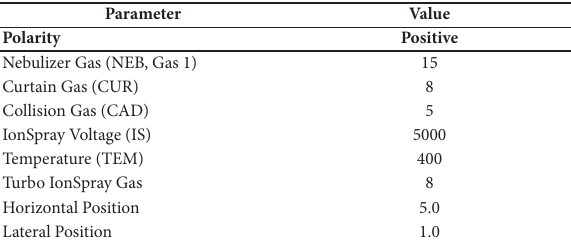
Table 1. Parameters of electrospray